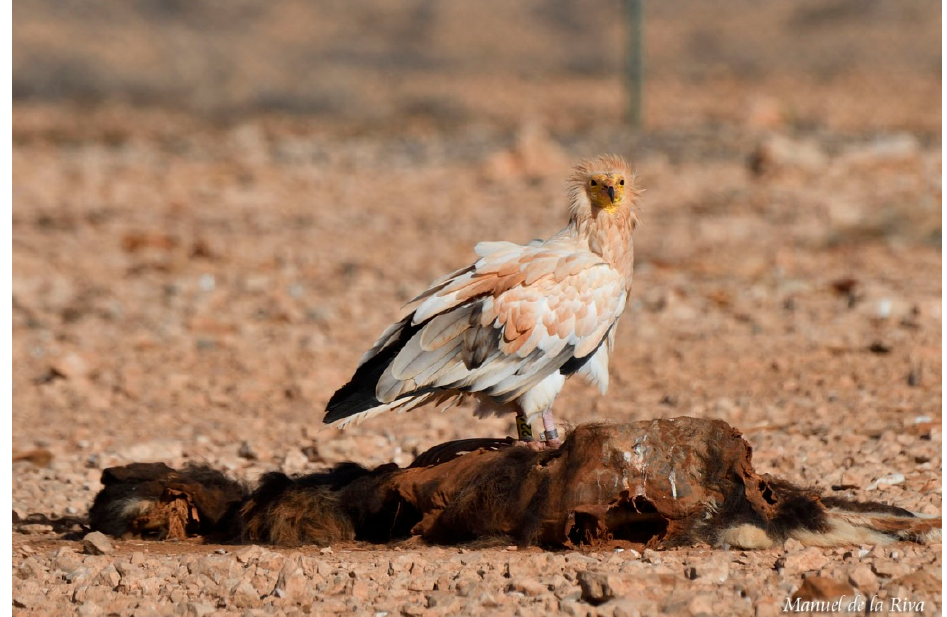
Figure 1. Canarian Egyptian Vulture feeding on a goat carcass in the supplementary feeding station located in the center of Fuerteventura Island. Photography© Manuel de la Riva.